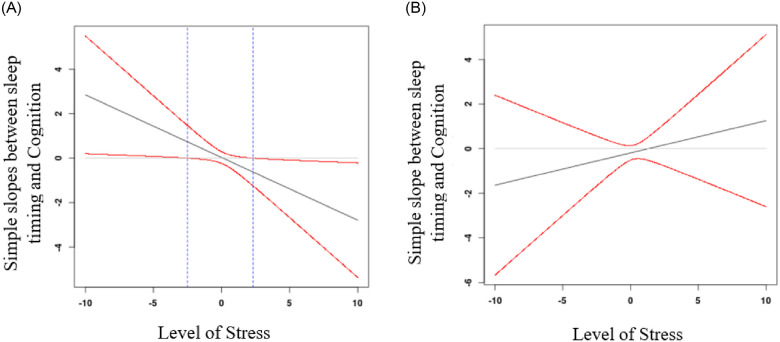
a. Johnson-Neyman regions of significance showing that for younger mothers, the effect size of the association between sleep timing and cognition is positive at low levels of stress and negative at high levels of stress. Red lines represent the confidence intervals. Area in between the blue lines represents where the confidence interval includes zero, thus, the region where simple slopes between sleep timing and cognition are non-significant. Areas outside the blue lines represent significant slopes. b. Johnson-Neyman regions of significance showing that for older mothers, the effect size of the association between sleep timing and cognition do not vary much across levels of chronic stress. Red lines represent the confidence intervals. Absence of blue lines indicate that none of the slopes are significant.